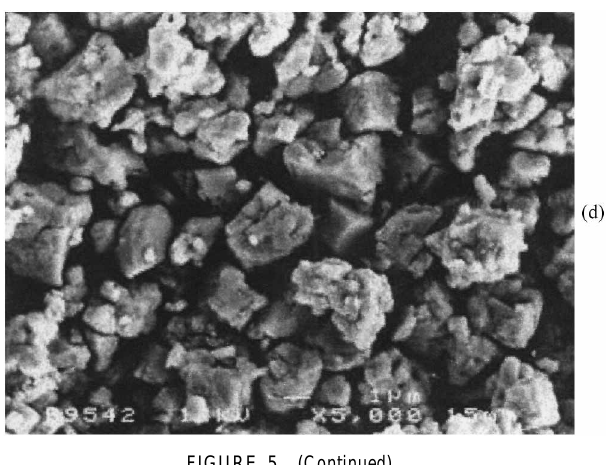
Figure 8. The parametric equations representing temperature dependence of the terminal capacitance and the relative dielectric constant in conjunction with the computed values of TCC and TCK are documented in Table I. Overall, the device capacitance varies within a very narrow band in the measurement temperature